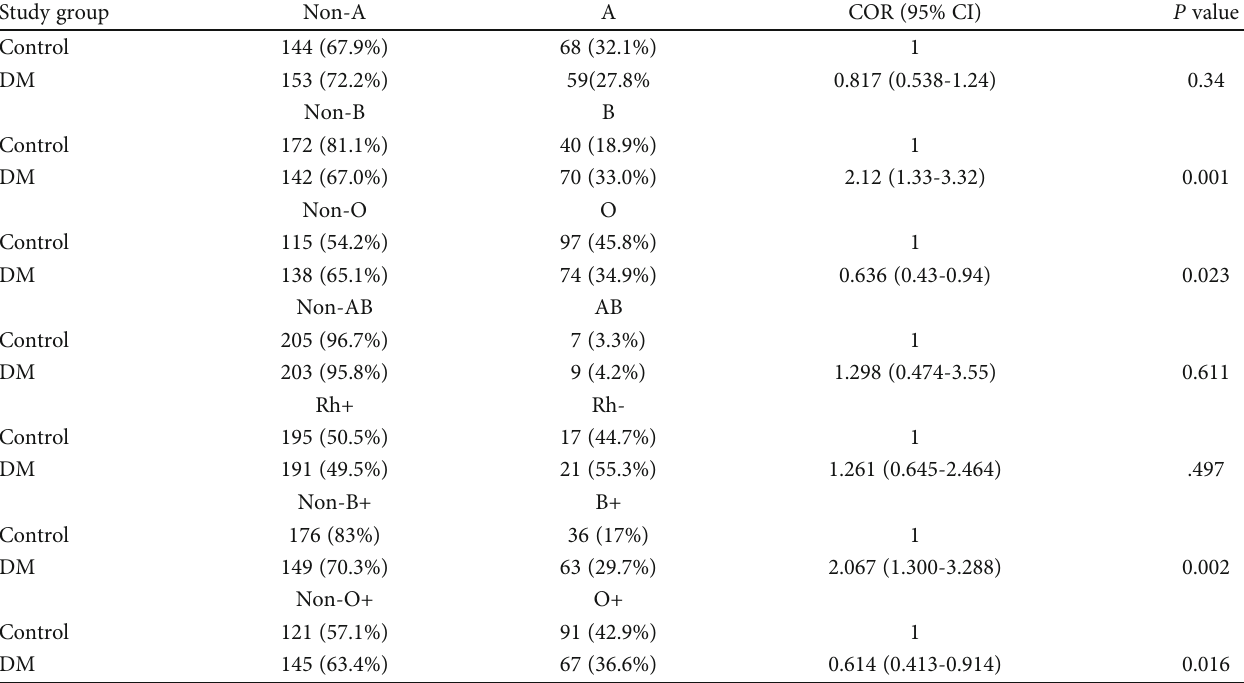
Table 3: Association of the ABO and Rh blood group phenotypes with T2DM at FHCRH, Bahir Dar, Northwest Ethiopia, 2019 ( n = 424 ). Study